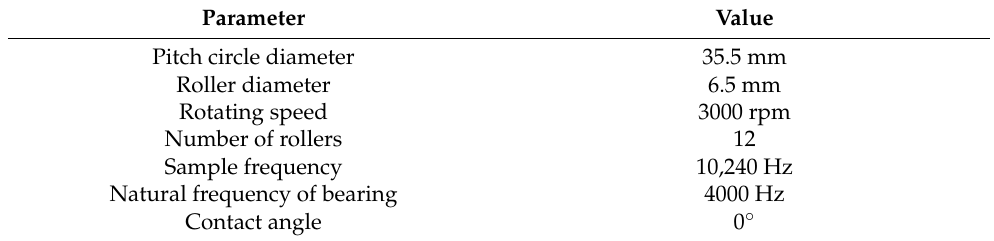
Table 1. Bearing